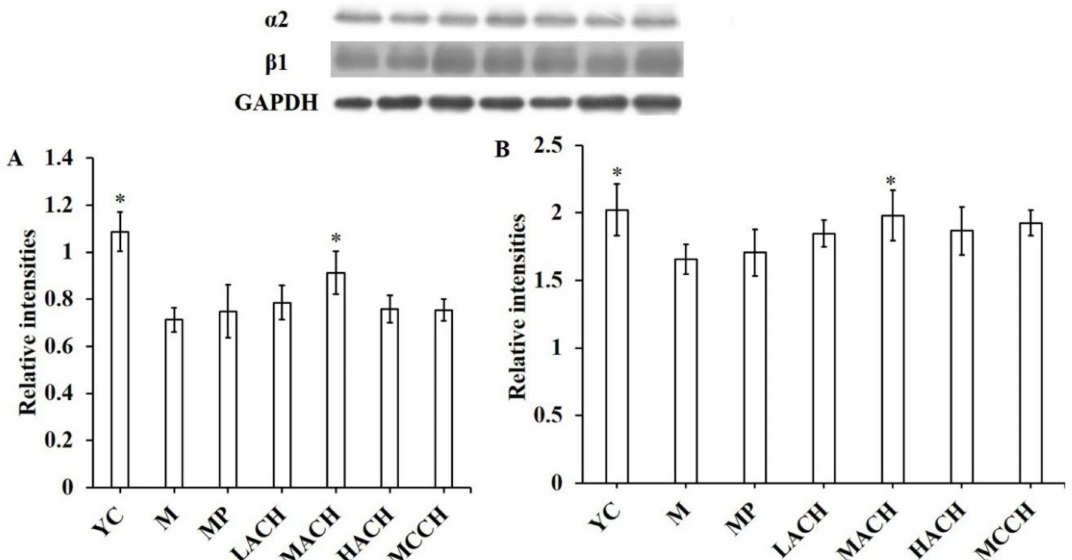
Figure 4. Effect of collagen hydrolysates on the expression of the α 2 β 1 integrin receptor in chronologically aged mice. GAPDH, glyceraldehyde-3-phosphate dehydrogenase. ( A ) α 2 subunit; ( B ) β 1 subunit. YC, young control group; M, model group; MP, medium dose of proline; LACH, MACH and HACH represent the low, medium and high dose of ACH, respectively; MCCH, medium dose of CCH. * means a significant difference was observed compared to M group ( p <